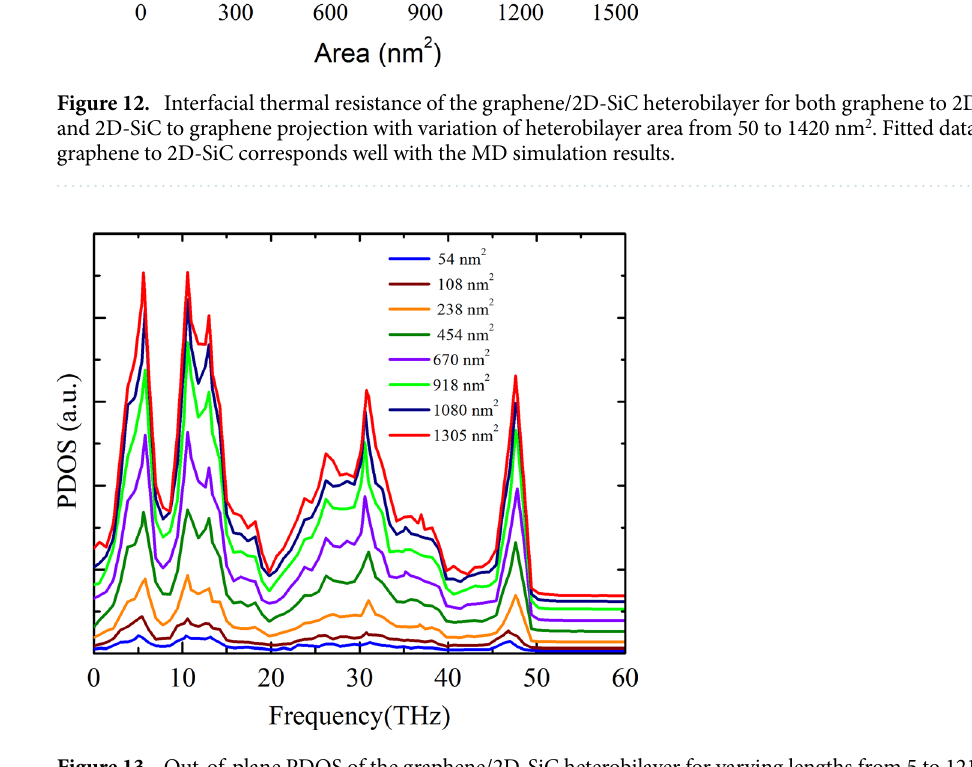
Figure 13. Out-of-plane PDOS of the graphene/2D-SiC heterobilayer for varying lengths from 5 to 121 nm with a fixed-width of 10.8 nm at 300